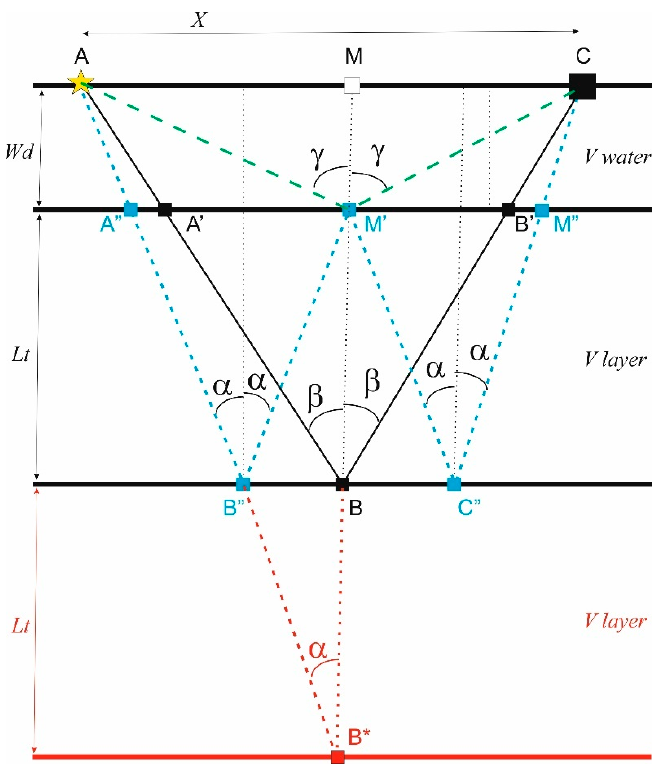
Figure 2. Ray paths from a source (point A) to a receiver (point C): primary reflections from the seafloor (dashed green line) and the layer bottom (continuous black line), and an intrabed multiple reflection (dashed blue line). The red lines indicate a virtual specular layer below the actual one and a virtual ray path.